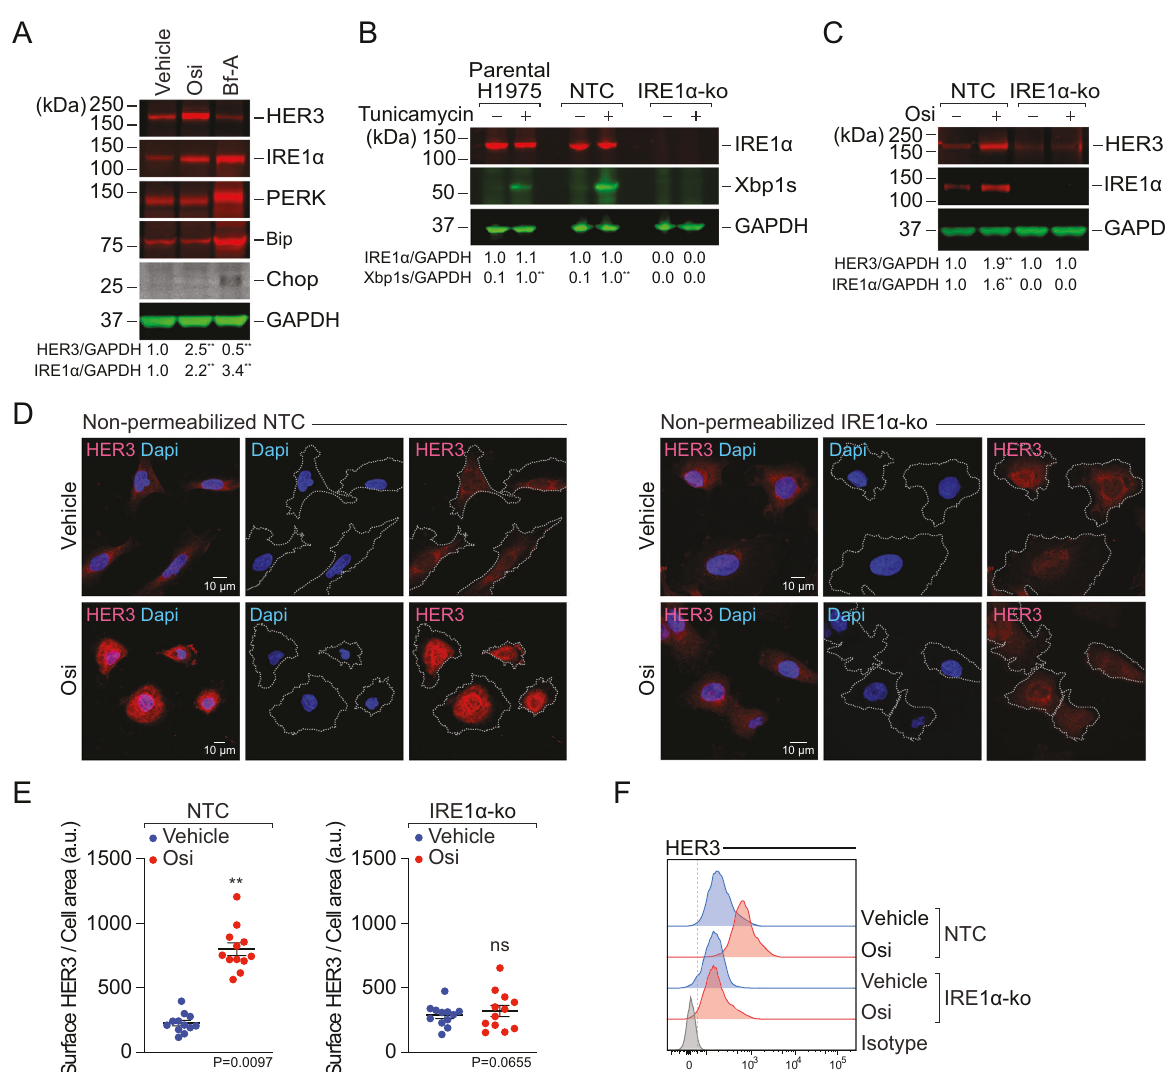
Fig. 2 IRE1 α is required for osimertinib to trigger HER3 upregulation in the cell surface. A Near-infrared quantitative westernblot analysis of H1975 cells treated with 200 nM osimertinib (Osi) or ER-stressor brefeldin-A (Bf-A, 0.5 μ g/ml) for 24 h. Densitometry levels of HER3 or IRE1 α relative to GAPDH were quanti fi ed from 3 independent replicates, and are shown under the representative blot lanes as normalized mean values (a.u.), where ** P < 0.01 vs . vehicle is shown, as calculated using unpaired t -test. Changes in PERK, Bip and Chop levels after Osi were non-signi fi cant. Full-size blots are in supplementary data. B Parental H1975 cells, or Cas9/CRISPR stable non-targeting control (NTC) and IRE1 α - ko H1975 cells were treated with ER-stressor tunicamycin (1 μ g/ml) for 3 h to assess functionality of IRE1 α . Densitometry levels of IRE1 α or spliced-Xbp1 (Xbp1s) relative to GAPDH were quanti fi ed from 3 independent replicates (a.u.), and are shown under the representative blot lanes as mean values, internally-normalized per cell type; ** P < 0.01 vs . vehicle as calculated using unpaired t -test. Full-size blots are shown in supplementary data. C Cas9/CRISPR stable NTC or IRE1 α -ko H1975 cells were treated with 200 nM osimertinib for 24 h. Densitometry levels of HER3 or IRE1 α relative to GAPDH were quanti fi ed from 3 independent replicates and are shown as mean values (a.u.) under the representative blot lanes, normalized per cell type; ** P < 0.01 vs . vehicle is shown where pertinent, as calculated using unpaired t -test. Full-size blots shown in supplementary data. D Cas9/CRISPR stable NTC or IRE1 α -ko H1975 cells were treated with 200 nM osimertinib (Osi) or vehicle for 24 h and processed for cell surface staining and confocal imaging as described in materials and methods, using an antibody targeting an extracellular epitope of HER3. Images showing surface HER3 (red) and nuclei (dapi, blue) are representative of 4 independent replicates; cell borders were obtained using Fiji-ImageJ and used for cell area quanti fi cations shown in panel E . E Surface HER3 levels relative to cell area were quanti fi ed from 4 independent experiments including the images shown in panel D (total 3 cells per repetition, 12 data points). Data are shown as means ± SEM. ** P < 0.01 vs . vehicle as indicated, using t -test. F Flow cytometry quanti fi cation of surface HER3 levels on live H1975 cells (NTC and IRE1 α -ko clones) treated with vehicle (blue) or osimertinib (Osi, 200 nM, red) for 24 h, as described in materials and methods, stained using an antibody against an extracellular epitope of HER3. Histograms are representative of 3 independent replicates. experiment as indicated in Figure legends. Full-size blots are shown in Biochemical) and deoxyribonuclease I (0.1 mg/ml; Boehringer Man- supplementary data (Fig. S7). nheim), incubated at 37 °C with agitation for 1 h, and then fi ltered through a 40-mm mesh. Samples were centrifuged, washed twice with PBS, and stained for 30 min at room temperature. Antibodies used are Flow cytometry measurements from tumors and cell lines detailed in section for reagents. For quanti fi cation of absolute number Dissected tumors were freshly cut into small pieces and resuspended in of cells, a de fi ned number of fl uorescent beads (Cell Sorting Set-up culture medium containing collagenase type 2 (1 mg/ml; Worthington Beads for UV Lasers, ThermoFisher) was added to each sample before Cell Death and Disease (2022)